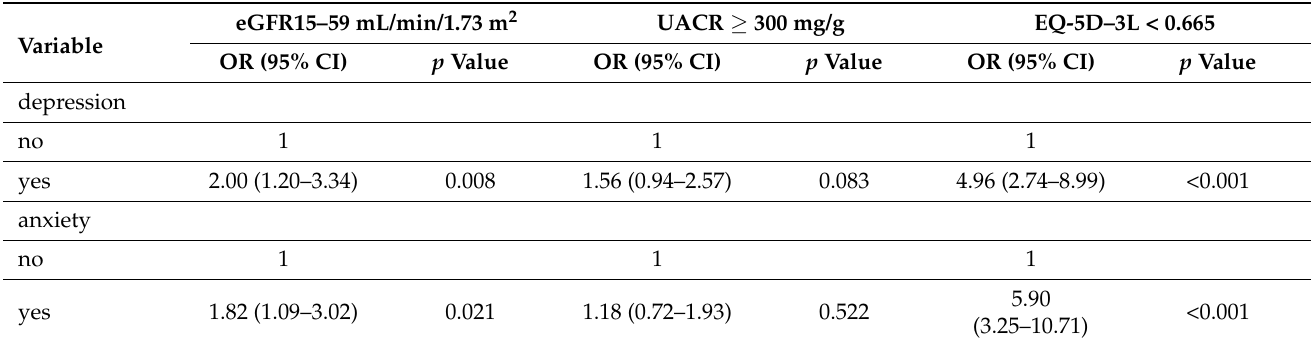
Table 6. Multivariate logistic regression analysis of the association of poor psychological status with deteriorating kidney function, macroalbuminuria and poor quality of life in DKD